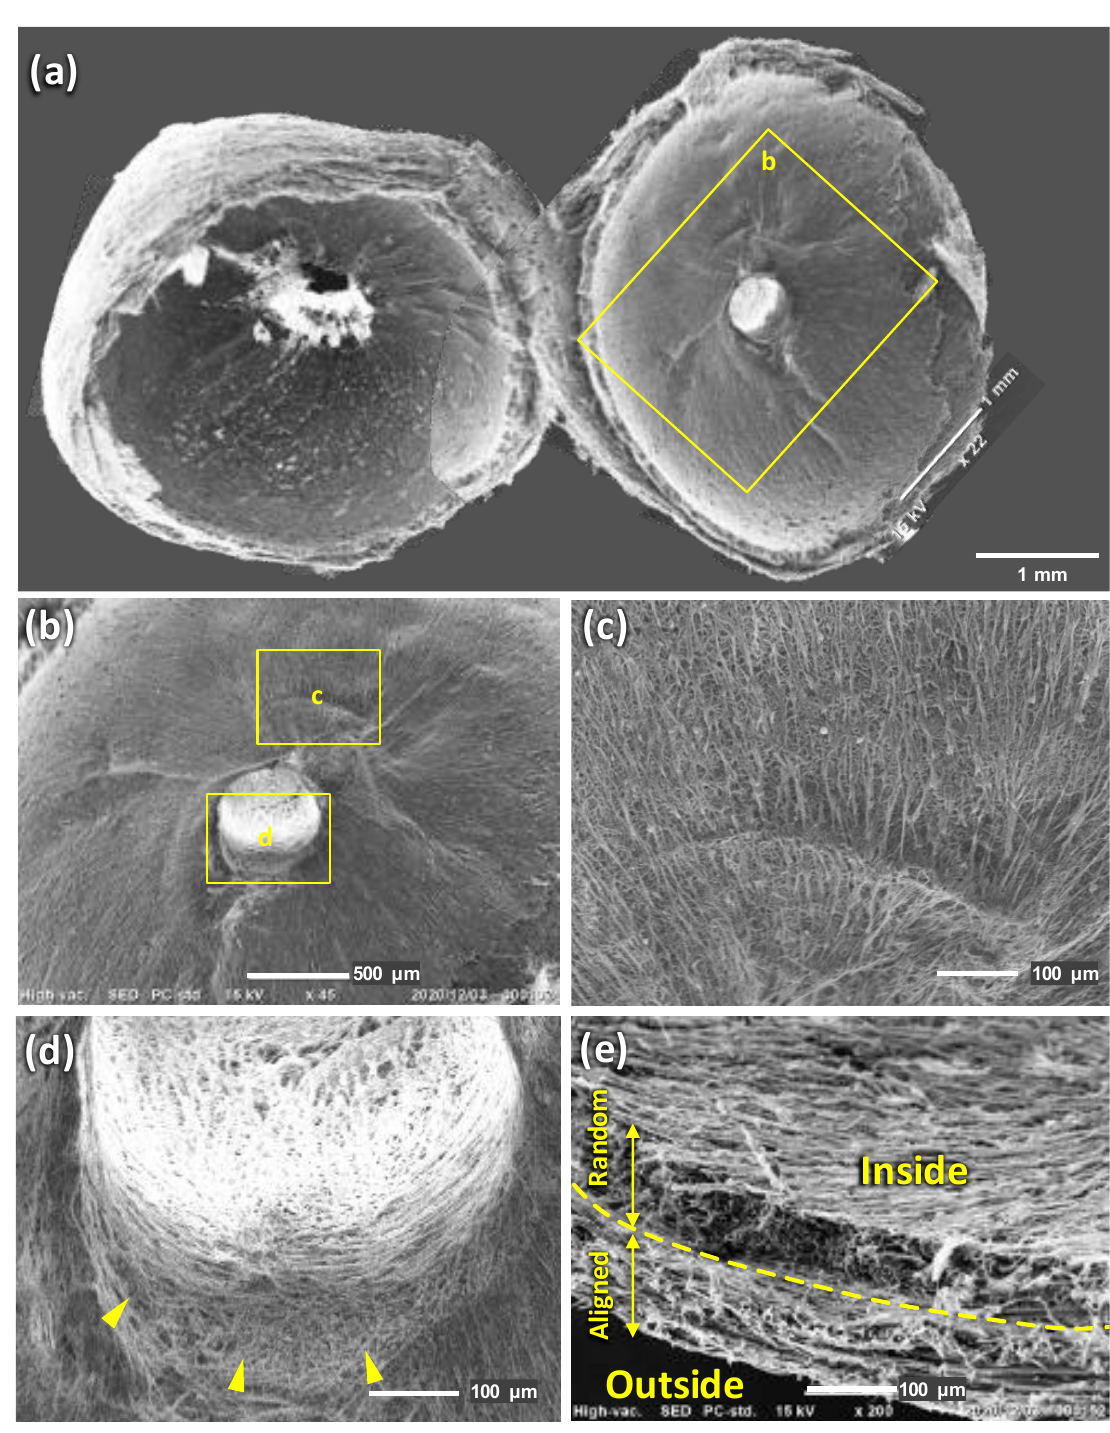
Figure 6. U-251 MG adhered to the inner surface of the nanofiber-mâché ball after a three-week culture. ( a ) Observation of the structure of the hollow nanofiber-mâché ball cut in half. ( b ) A cell layer tightly covered the inner surface after long-term culture. ( c ) The gradient in the concentration of the medium promoted cell alignment towards the duct exit. ( d ) Enlarged view of duct entrance. Cells oriented along aligned in the circumferential direction between the central sphere and ducts, but the periphery of the duct showed random towards the duct. (Curved arrow: circumferential fiber at the interface; arrowheads: fiber orientations on the periphery of the duct). ( e ) Invasion of cells (cross-sectional view). A layer of cells was covering the inner surface showed no obvious inva- sion into fibers.